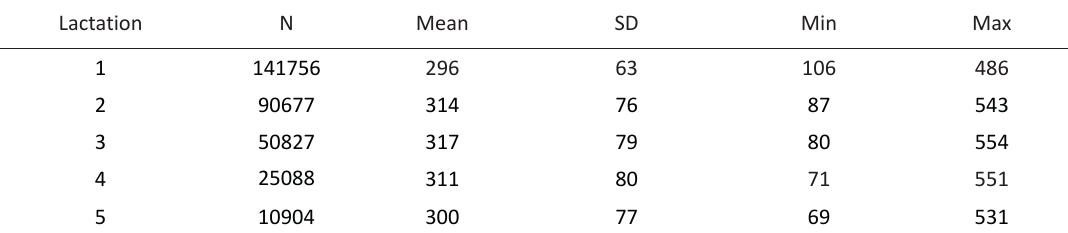
Table 6. Number of observations (N), mean, standard deviation (SD), minimum value (Min), and maximum value (Max) of the fat yield (kg) Lactation